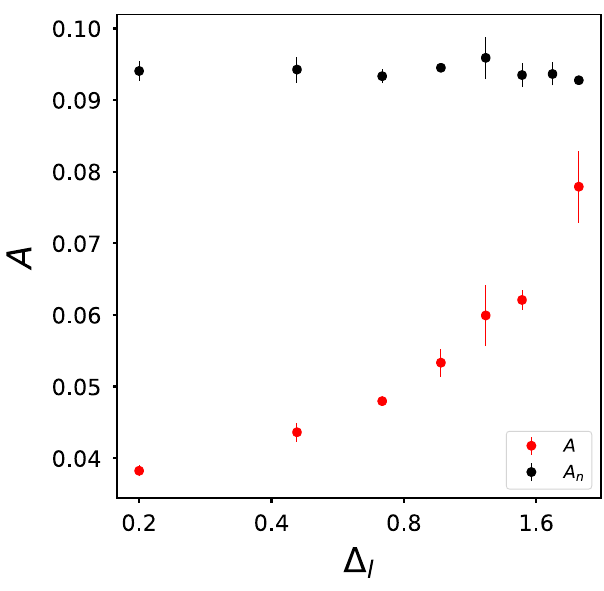
FIG. 12. Prefactors for the concentration ( A ) and the protein number ( A )obtained from the numerical solutionofthe stochastic n differential equations for different values of the parameter Δ error bars are obtained by using the standard deviation of the fluctuations of the prefactor for different promoter